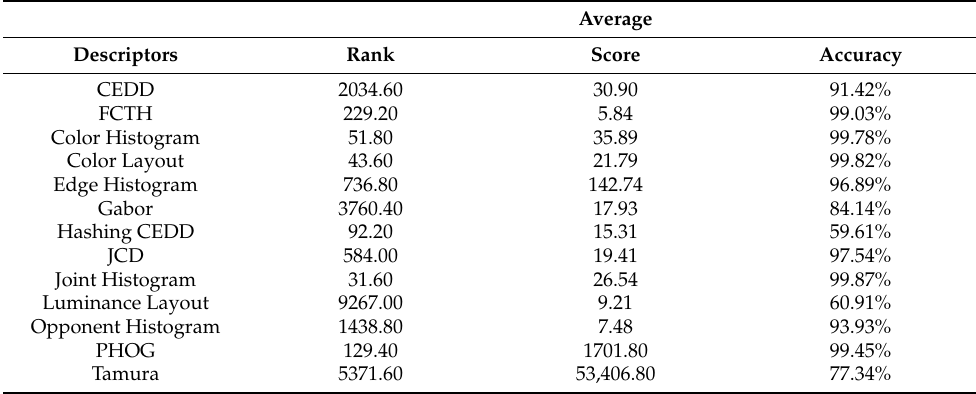
Figure 17. Average accuracy of retrieving cropped face images. Table 7. Descriptors’ performance for retrieving cropped face images.